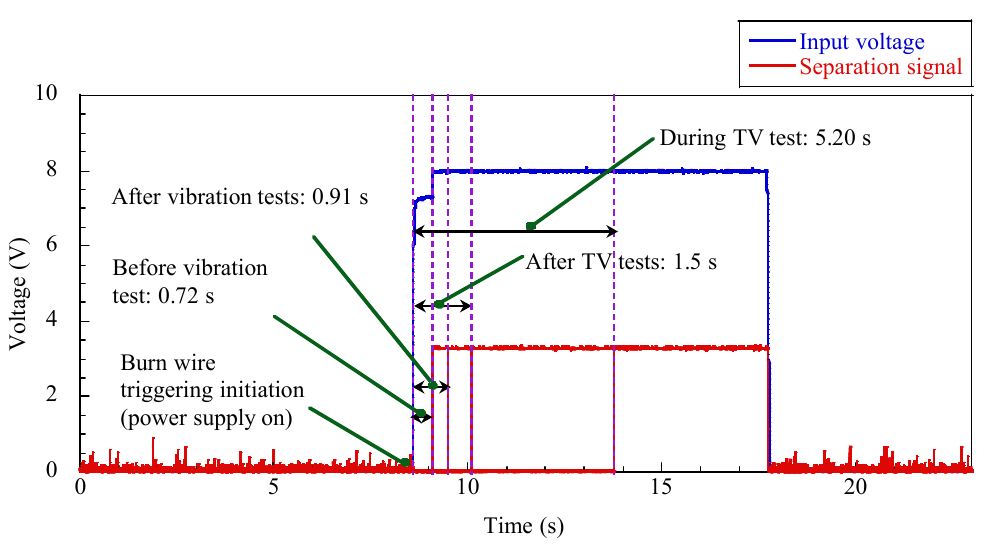
Figure 17. Summary of release time of the mechanism at each test event.